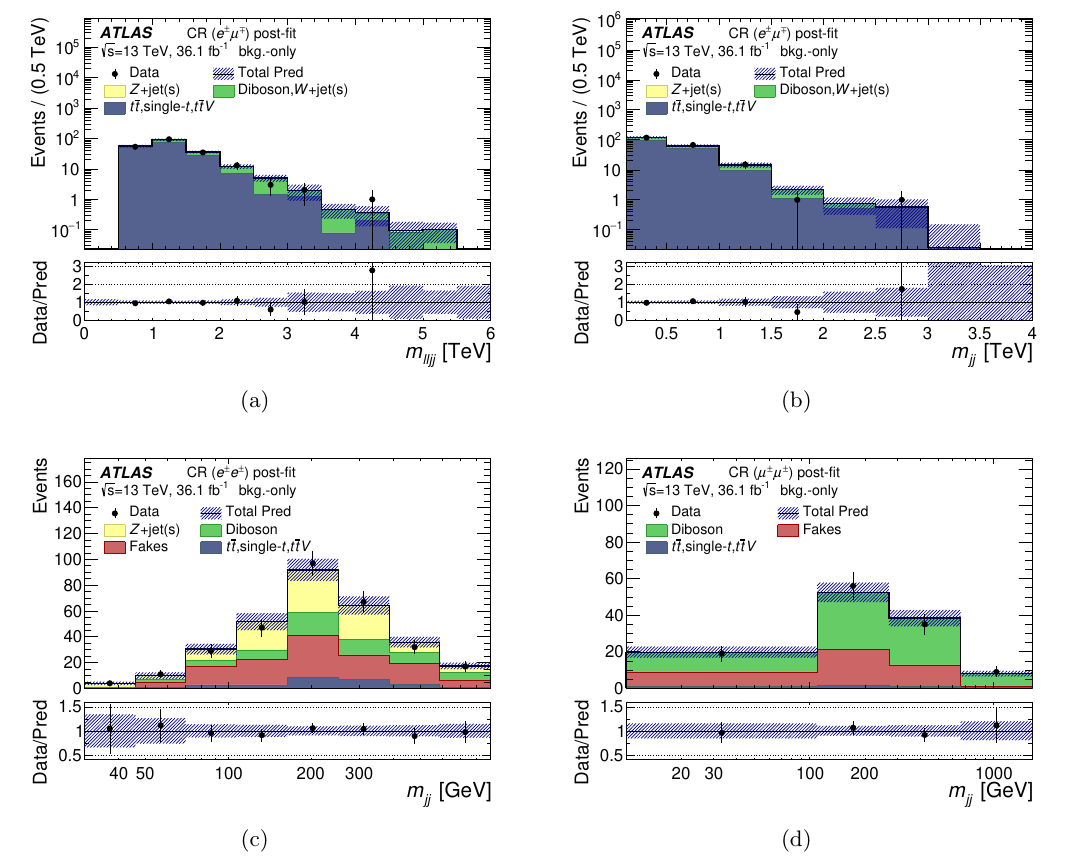
Figure 4 . Distributions for data and background predictions for discriminant variables in various control regions and channels after the background-only (cid:12)t: (a) m ‘‘jj in CR( e (cid:6) (cid:22) (cid:7) ), (b) m jj in CR( e (cid:6) (cid:22) (cid:7) ), (c) m jj in CR( e (cid:6) e (cid:6) ), and (d) m jj in CR( (cid:22) (cid:6) (cid:22) (cid:6) ). The hatched bands include all post- (cid:12)t systematic uncertainties. The correlation between sources of systematic uncertainties are taken into account. The last bin in each histogram contains the over(cid:13)ow.